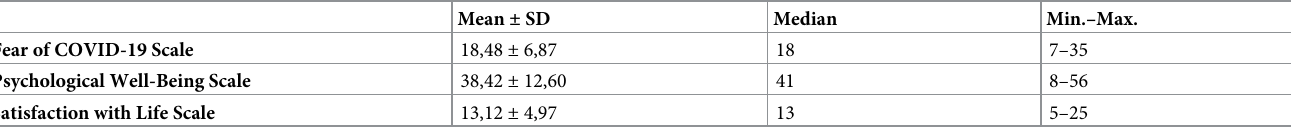
Table 2. Mean scores on the fear of COVID-19, psychological well-being, and satisfaction with life scales.